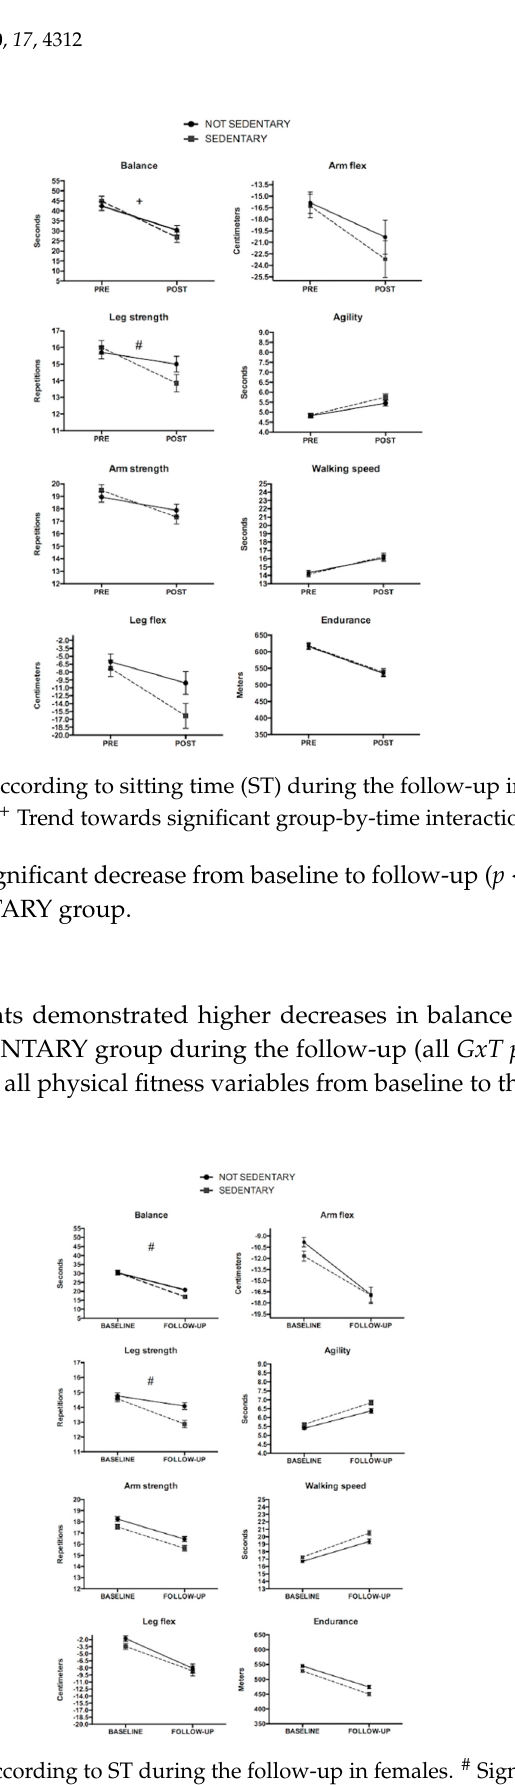
Figure 4. Fitness changes according to ST during the follow-up in females. # Significant group-by-time interaction. Both groups showed a significant decrease from baseline follow-up ( p < 0.05).